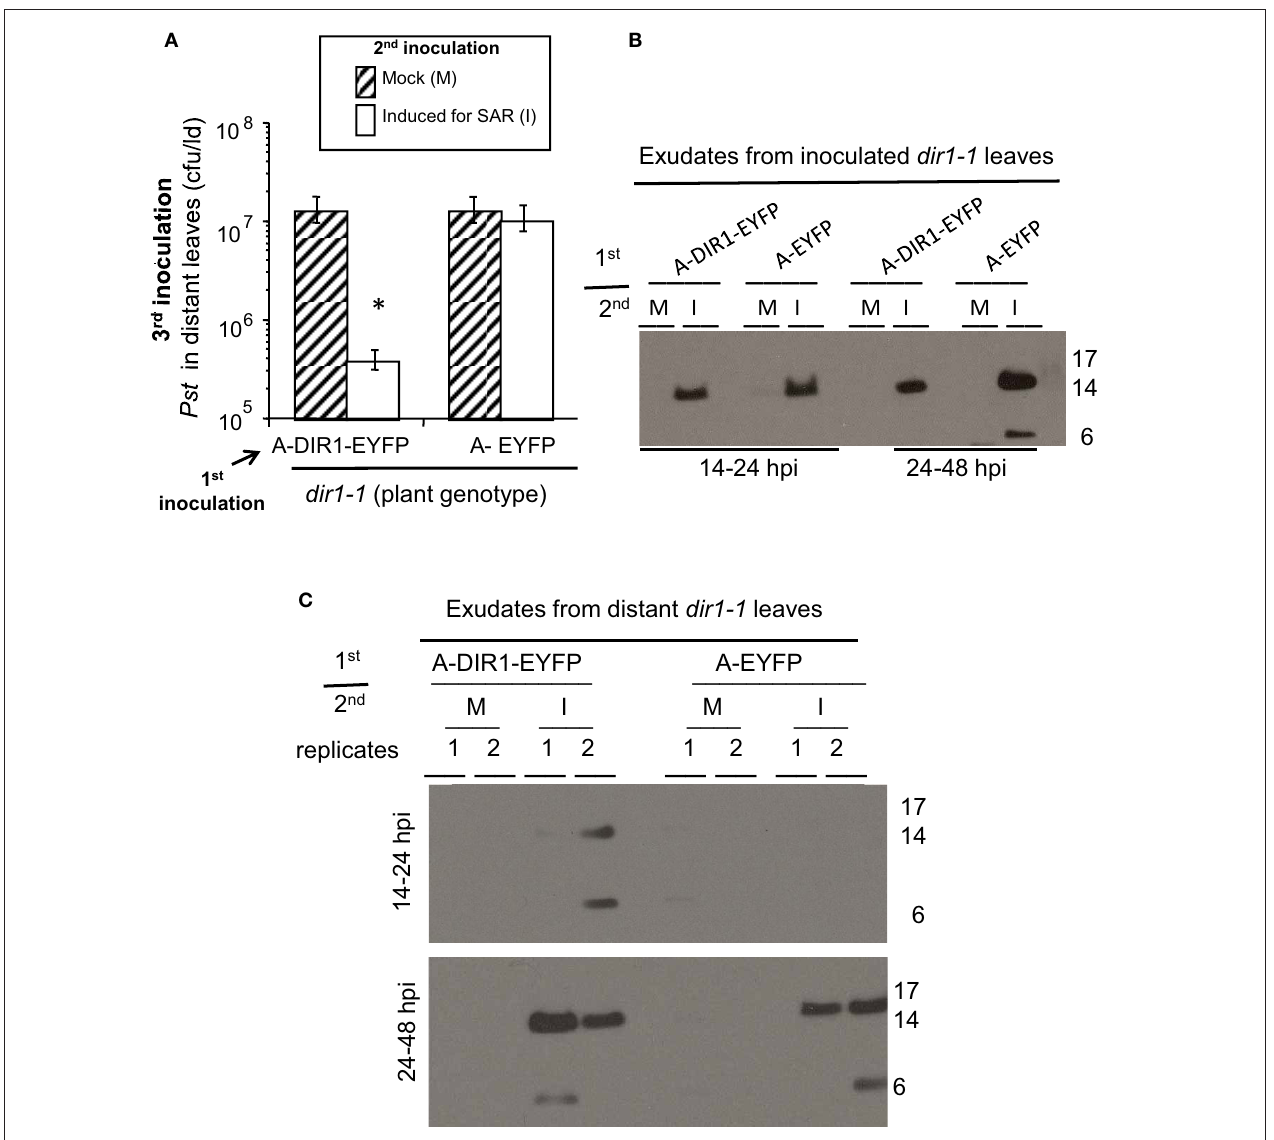
FIGURE 6 | DIR1-EYFP Agro-SAR assay and DIR1-antibody signals in distant leaf exudates. (A) The Agro-SAR assay was performed as illustrated in Figure S8. Petiole exudates were collected (14–48hpi) from lower leaves (Inoc) which received a 1st inoculation with either Agro EYFP or DIR1-EYFP, followed by a 2nd inoculation that was either mock (M) or with SAR-inducing